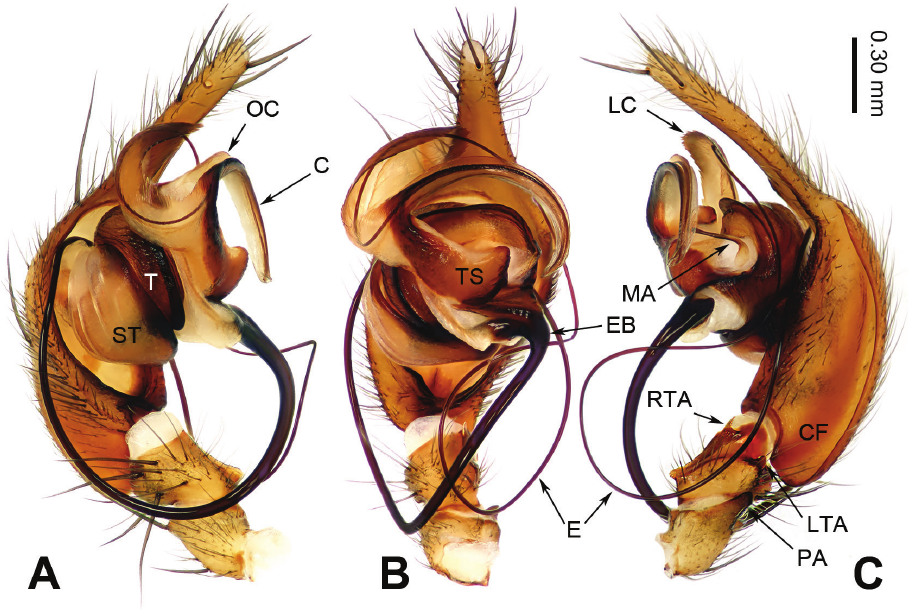
Figure 3. Left male palp of Guilotes qingshitanensis sp. n., holotype. A Prolateral view B Ventral view C Retrolateral